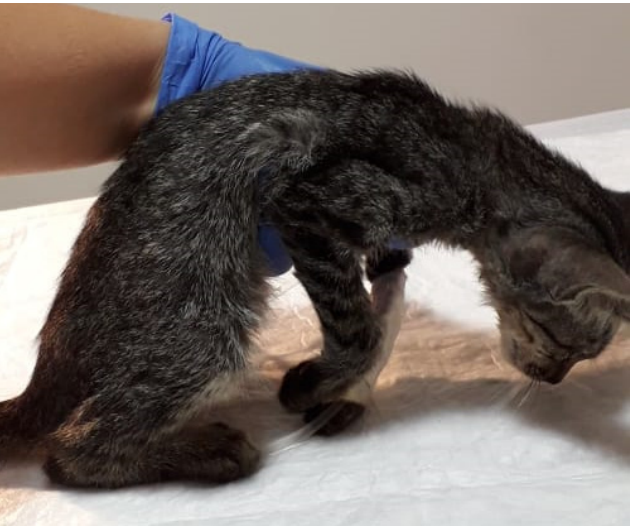
Figure 1. The kitten of the present study showing obtundation and non-ambulatory tetraplegia.